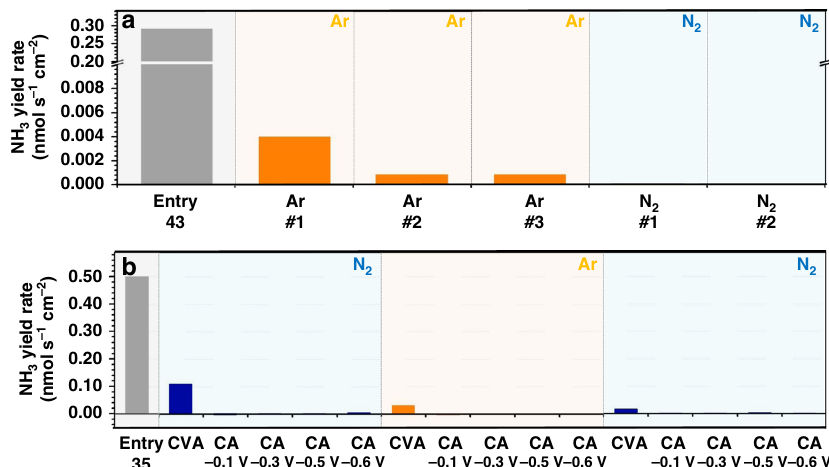
Fig. 3 CN x and VN: NRR vs. decomposition. NH 3 formation during the electroreduction of a CN x - and b VN-modi fi ed electrodes previously reported in the literature (entries 35 and 43 in Supplementary Table 1), and as measured in our laboratory at different stages of a continuous test. Electrolyte solutions and potentials (vs. reversible hydrogen electrode) used in tests are provided in corresponding panels; further experimental details can be found in Supplementary Figs. 1 and 2 and ref. 25 (CVA = cyclic voltammetry, CA =